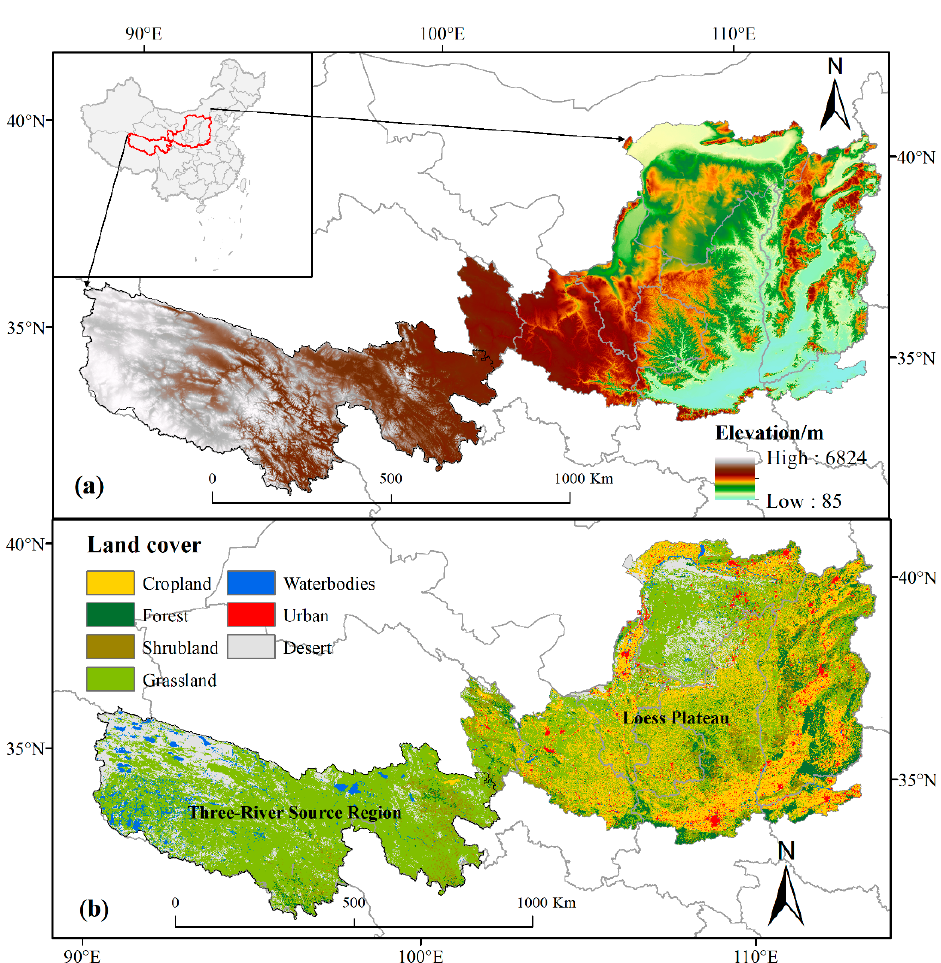
Figure 1. Location and topographical features ( a ) and land cover types ( b ) of the study area.